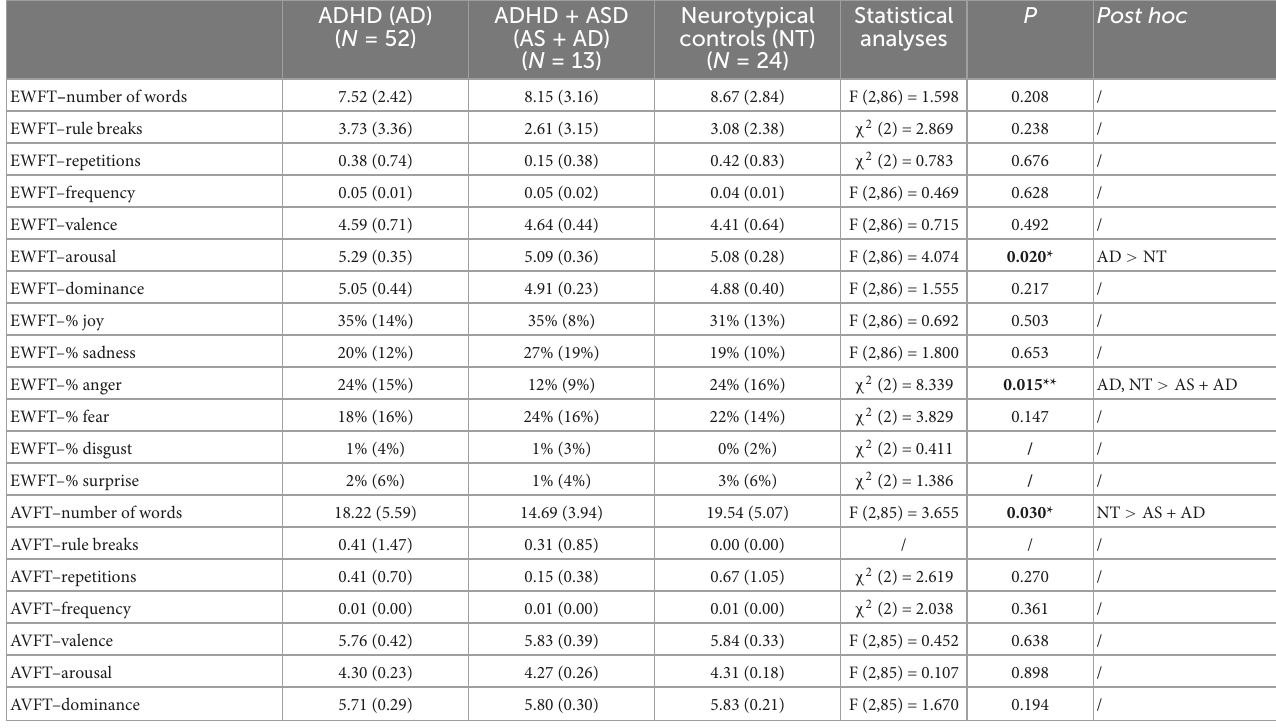
TABLE 3 Emotional word fluency test (EWFT) and action verb fluency test (AVFT) characteristics in each group.